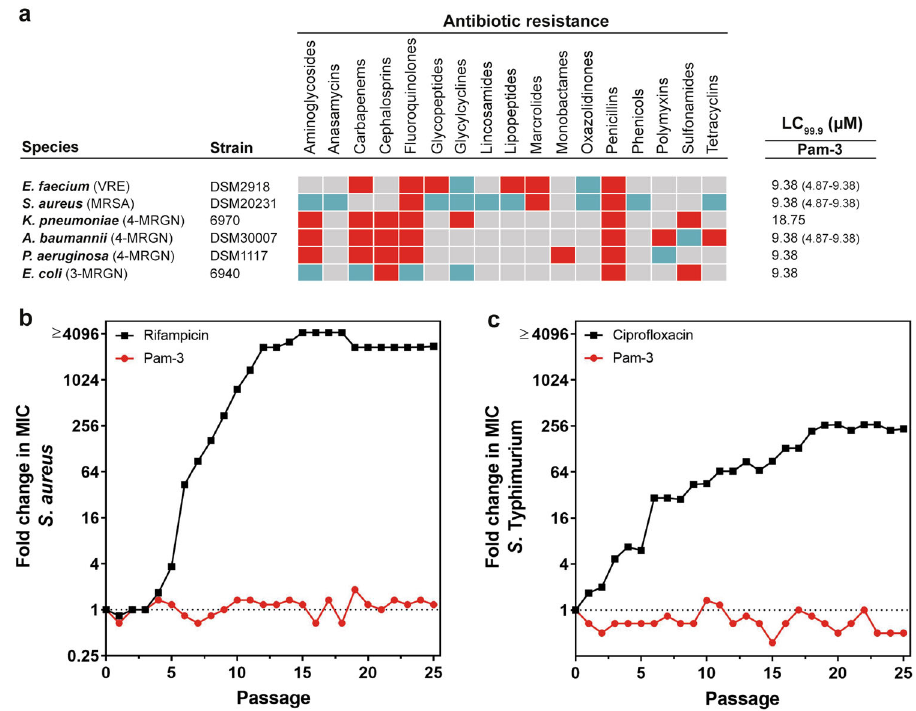
Fig. 2 Pam-3 kills multidrug-resistant ESKAPE pathogens and resistance was not selected. a Susceptibility of multidrug-resistant ESKAPE ( E. faecium , S. aureus , K. pneumoniae , P. aeruginosa and E. coli ) pathogens to antibiotics and Pam-3. Bacteria susceptible to all (blue boxes) or intermediate/resistant to at least one (red boxes) of the antibiotics per class. Gray boxes are shown if the susceptibility to agents in that class was not assessed. Results are expressed as the LC 99.9 , the lowest peptide concentration in micromolar that resulted in ≥ 99.9% killing. Results are medians (and ranges) of three independent experiments. If no range is indicated, then the LC 99.9 was identical in all experiments. b , c Resistance development of S. aureus ATCC 25923 ( b ) and S . Typhimurium DSM554 ( c ) to Pam-3 (red line) and the antibiotics rifampicin and cipro fl oxacin (black line), respectively. Values are fold changes (in log 2 ) in minimal inhibitory concentration (MIC) relative to the MIC of the fi rst